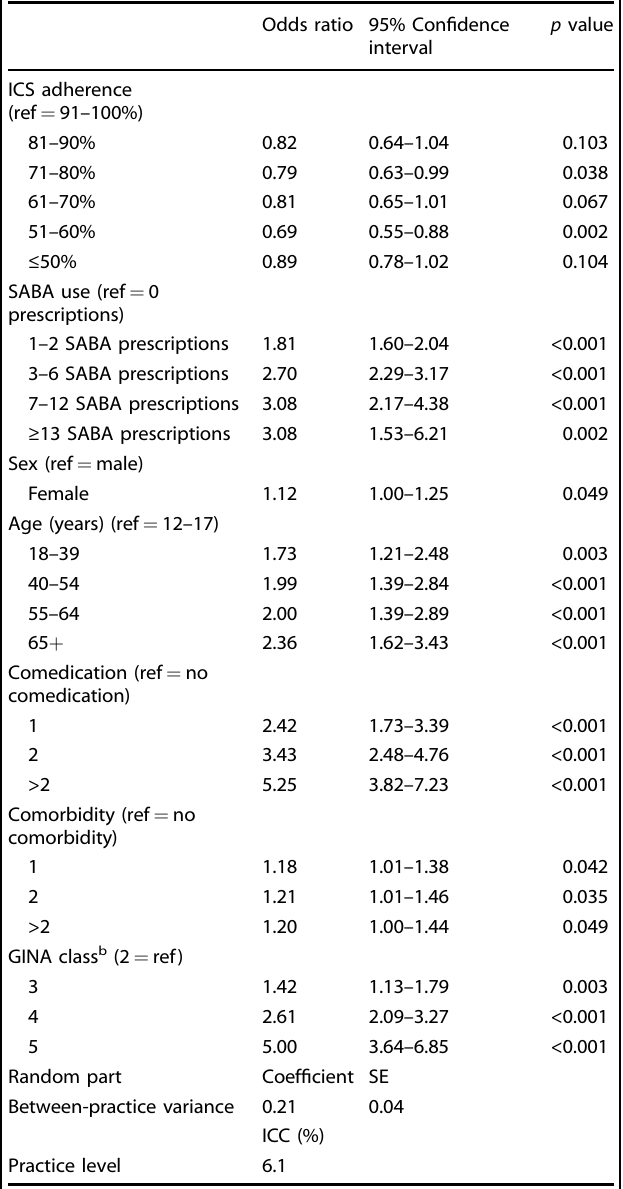
Table 2. Results of multilevel logistic regression analysis showing whether ICS adherence and SABA use were associated with having one or more exacerbations compared to having none in the sample of